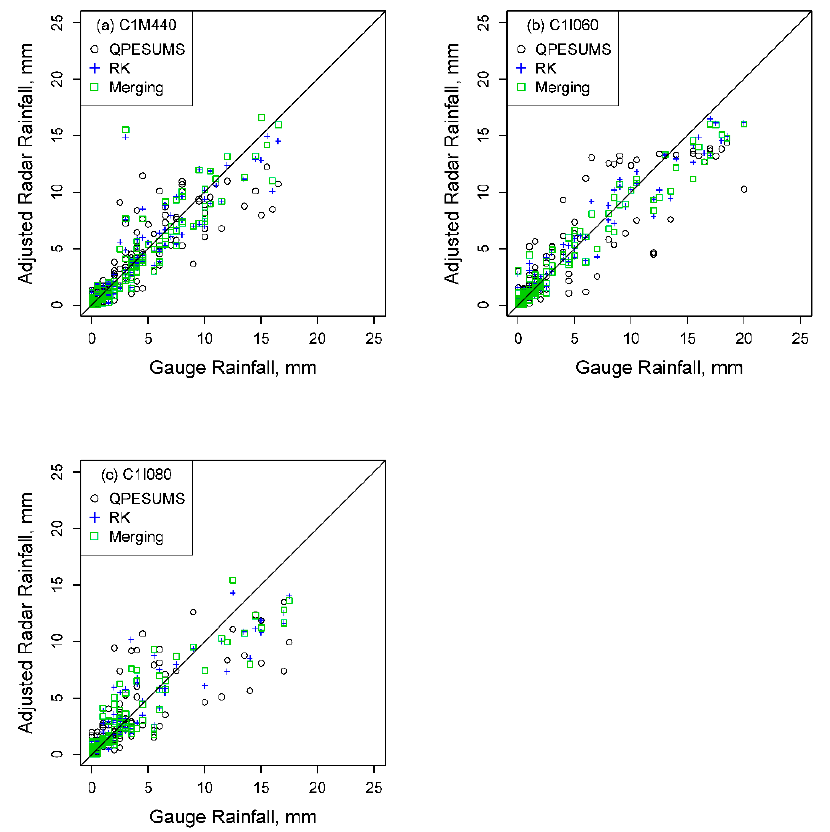
Figure 7. Comparison plots between gauge measurements and rainfall data from RK, merging, and QPESUMS at ( a ) C1M440, ( b ) C1I060, and ( c ) C1I080 for the event of Typhoon Kalmaegi. Table 5. RMSE and CE for the unadjusted QPESUMS data and adjusted radar rainfall values using RK and merging for stations inside the watershed boundary during the event of Typhoon Morakot. The values of the percentage reduction (% Red.) in the RMSE and percentage improvement (% Imp.) in CE are also